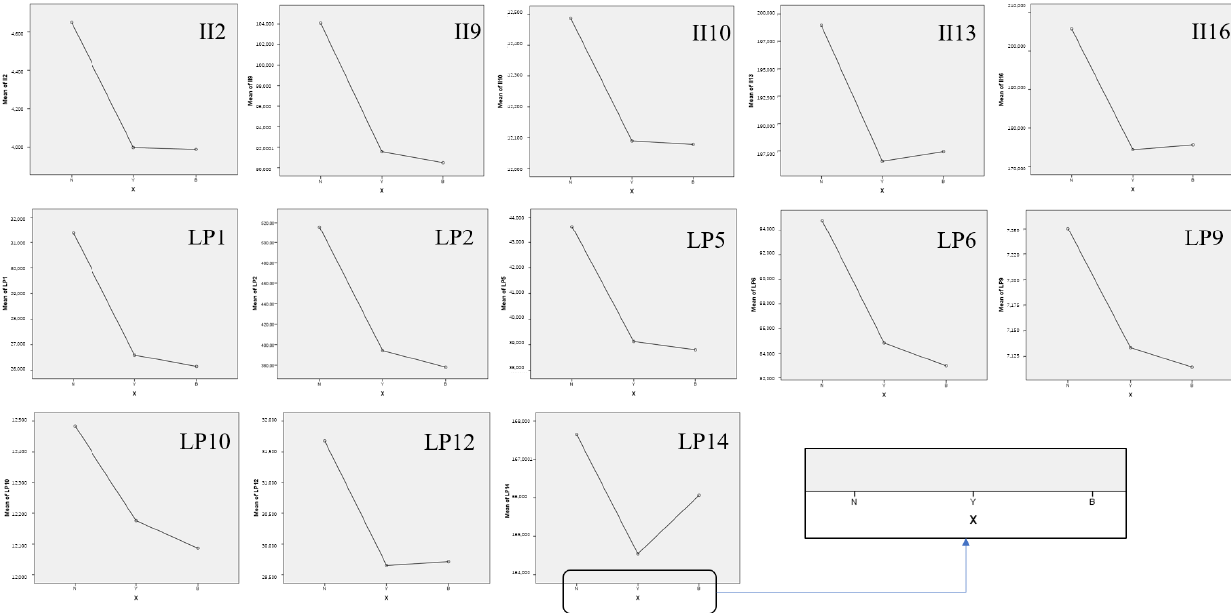
Figure 9. Mean Plots (Negative growth). Table 3. ANOVA.